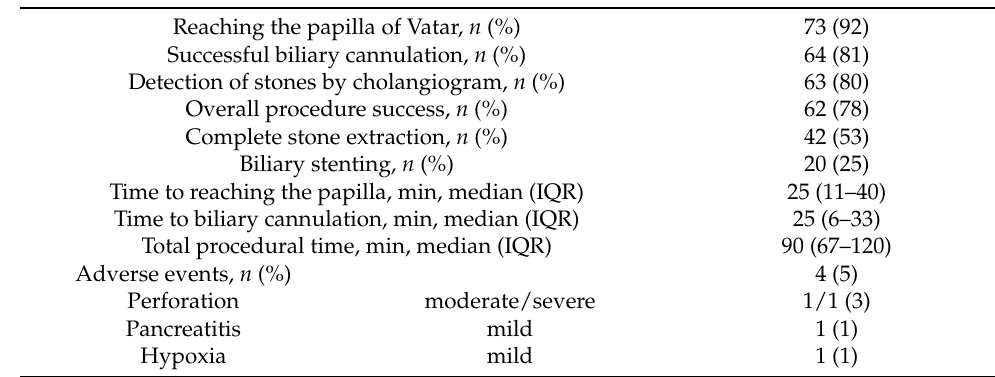
Table 2. Results of initial BE-ERCP ( n =